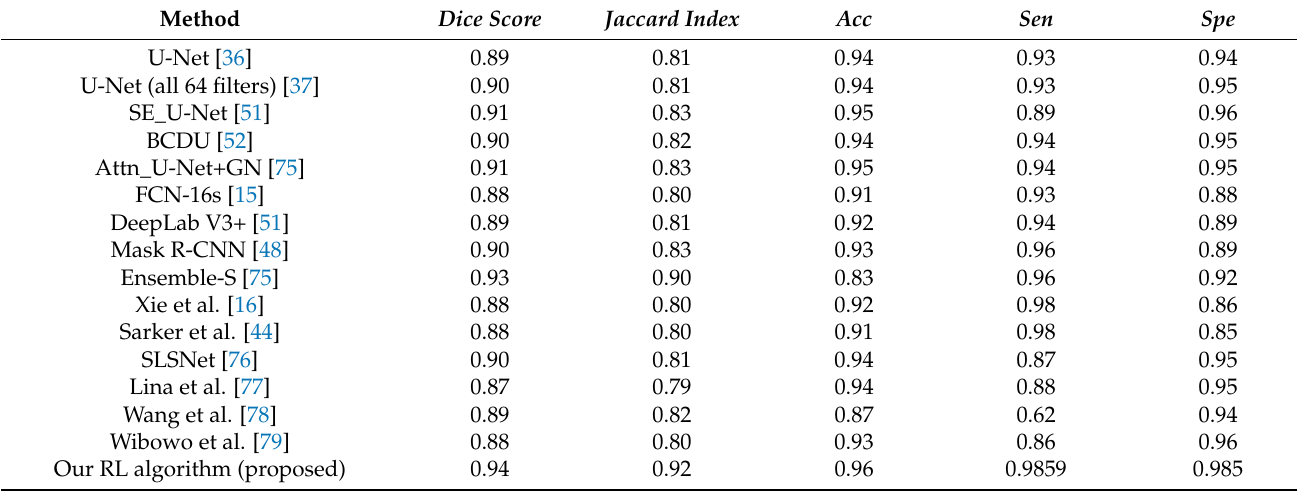
Table 2. The proposed RL model’s segmentation efficiency is compared to state-of-the-art methods. The statistical measures such as Dice score, Jaccard index, Acc , Sen , and Spe are evaluated on the PH2 dataset.